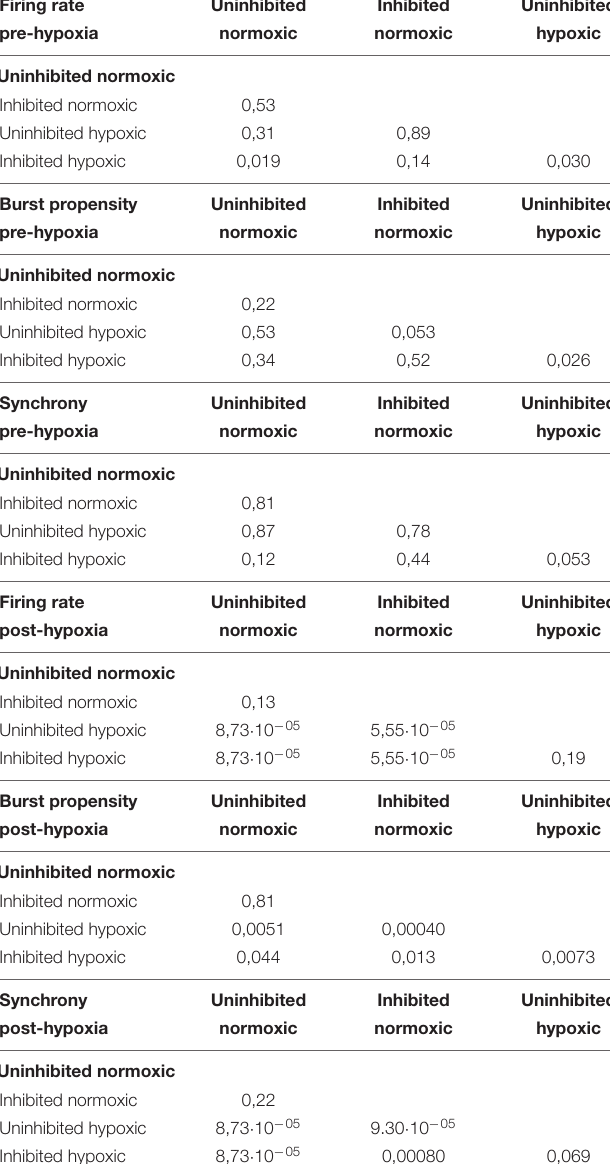
TABLE 2 | Statistical comparison of network activity. Figure 2C , as well as specific markers for motor neurons, shown in Figures 2A,B